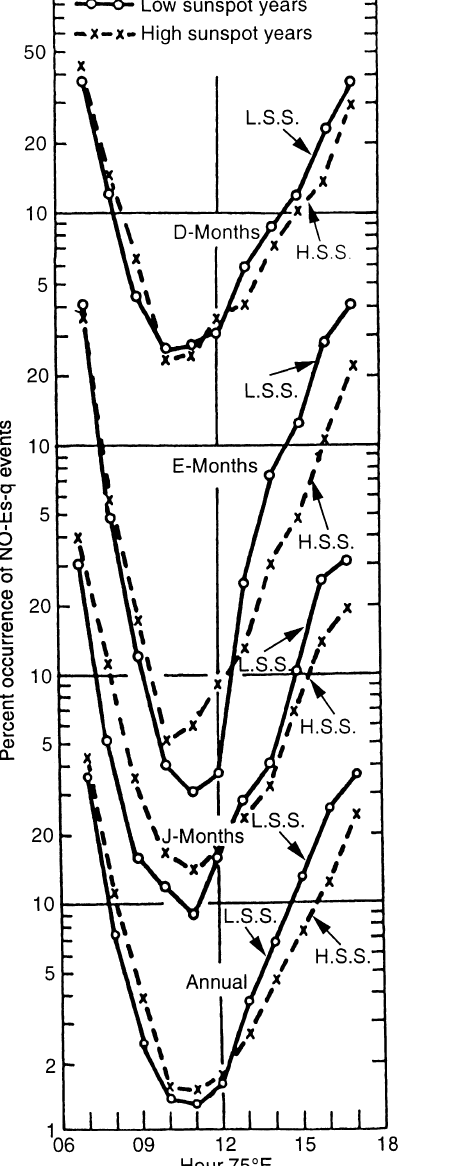
Fig. 1. Daily variation of No - E s - q events at Kodaikanal averaged for the D, E and J-months of low and high sunspot years